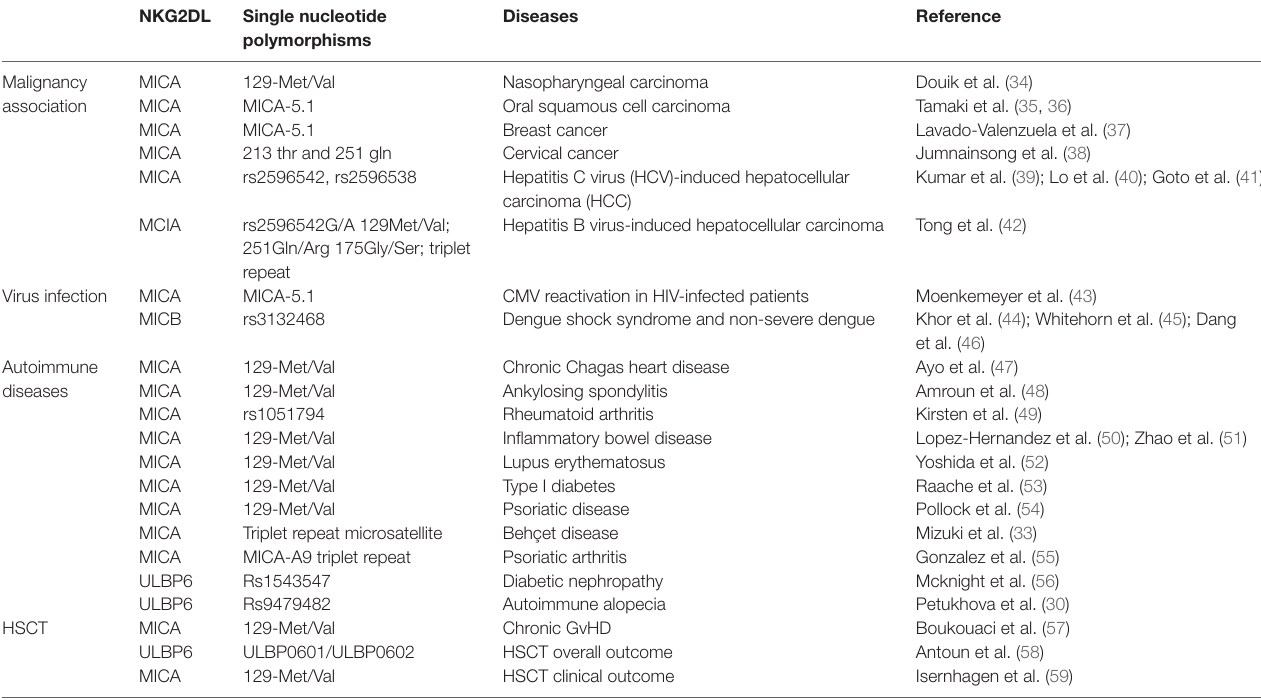
TABLe 1 | The clinical relevance of polymorphism within NKG2D